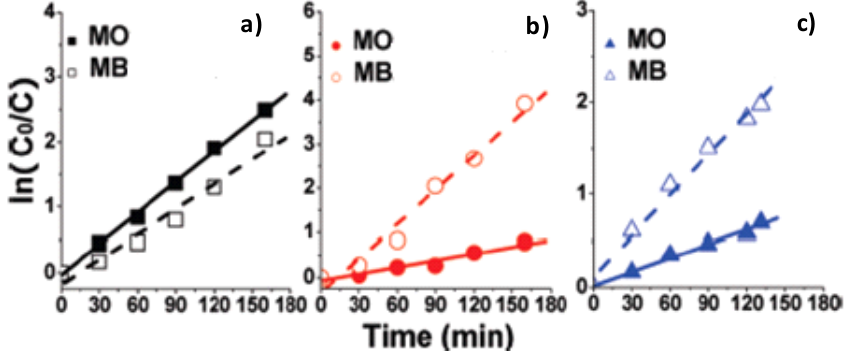
Figure 13. Comparison of photocatalytic decomposition of methyl orange (MO) and methylene blue (MB) by hollow TiO microspheres (HTS) before and after surface 2 modification: ( a ) As-prepared fluorinated HTS; HTS modified ( b ) by NaOH washing and ( c ) by calcination at 600 °C. Adapted with permission from ref. [62]. Copyright 2010 American Chemical